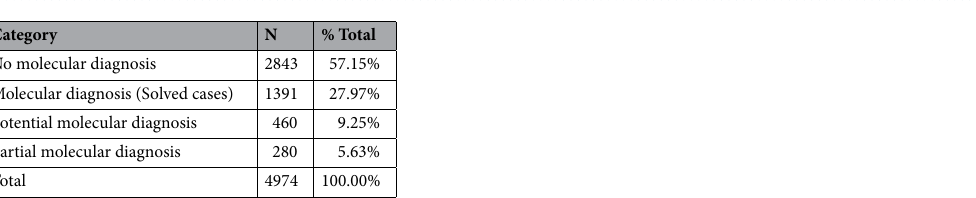
Figure 3. Analysed cases among groups of diseases. N = number of analysed cases; %: percentage of total (n = 4974) analysed cases.